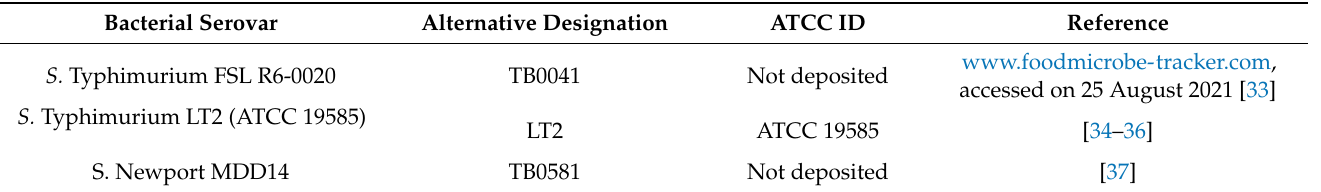
Table 2. Bacterial serovars for our